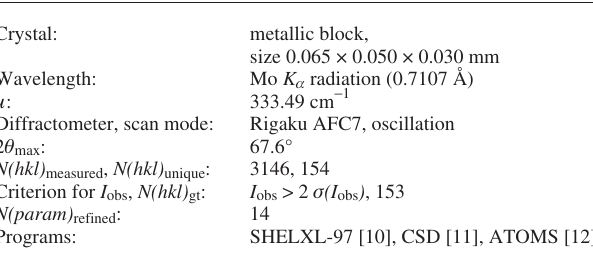
Table 1. Data collection and